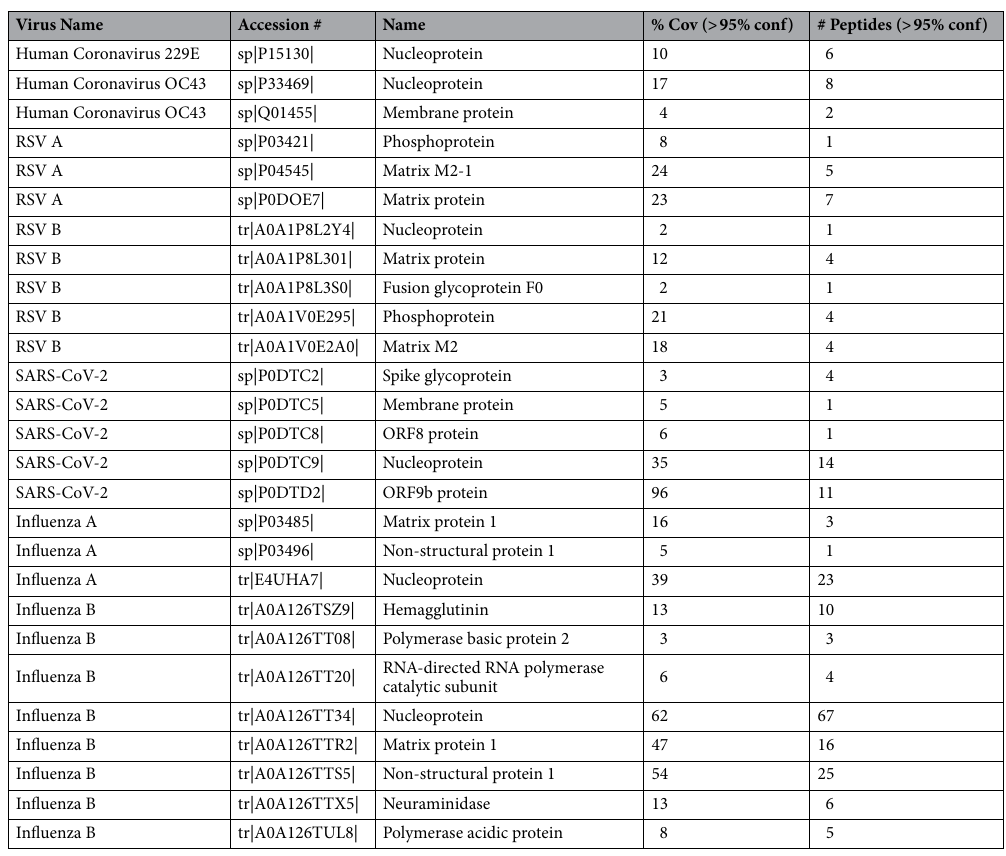
Table 2. Sequence coverage for all respiratory viruses from analysis of serum-free cultures. Viruses 229E, OC43, RSV-A, RSV-B and SARS-CoV-2 were analysed with a short microflow method, whereas Influenza A and B were analysed with nanoflow LC, resulting in inferior sequence coverage for the former